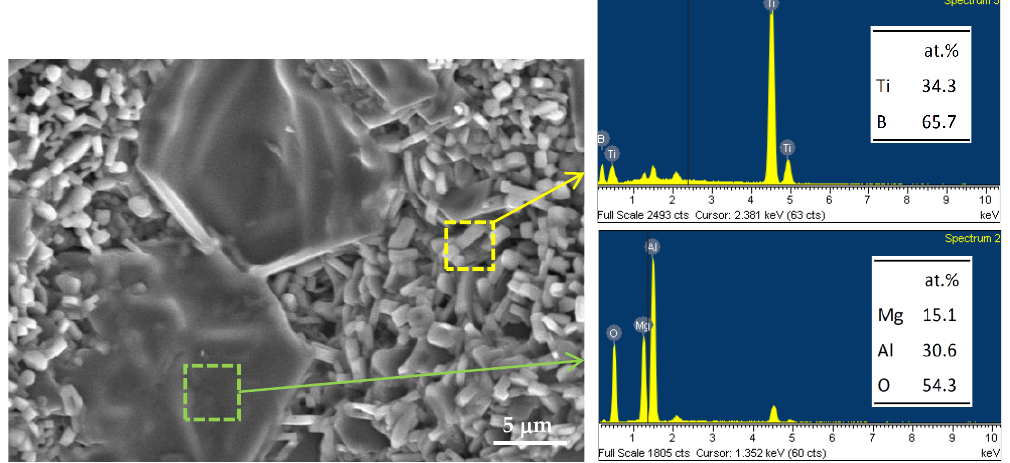
Figure 8. SEM image and EDS spectra of TiB 2 /MgAl 2 O 4 composite obtained from the SHS reaction of Equation (4).